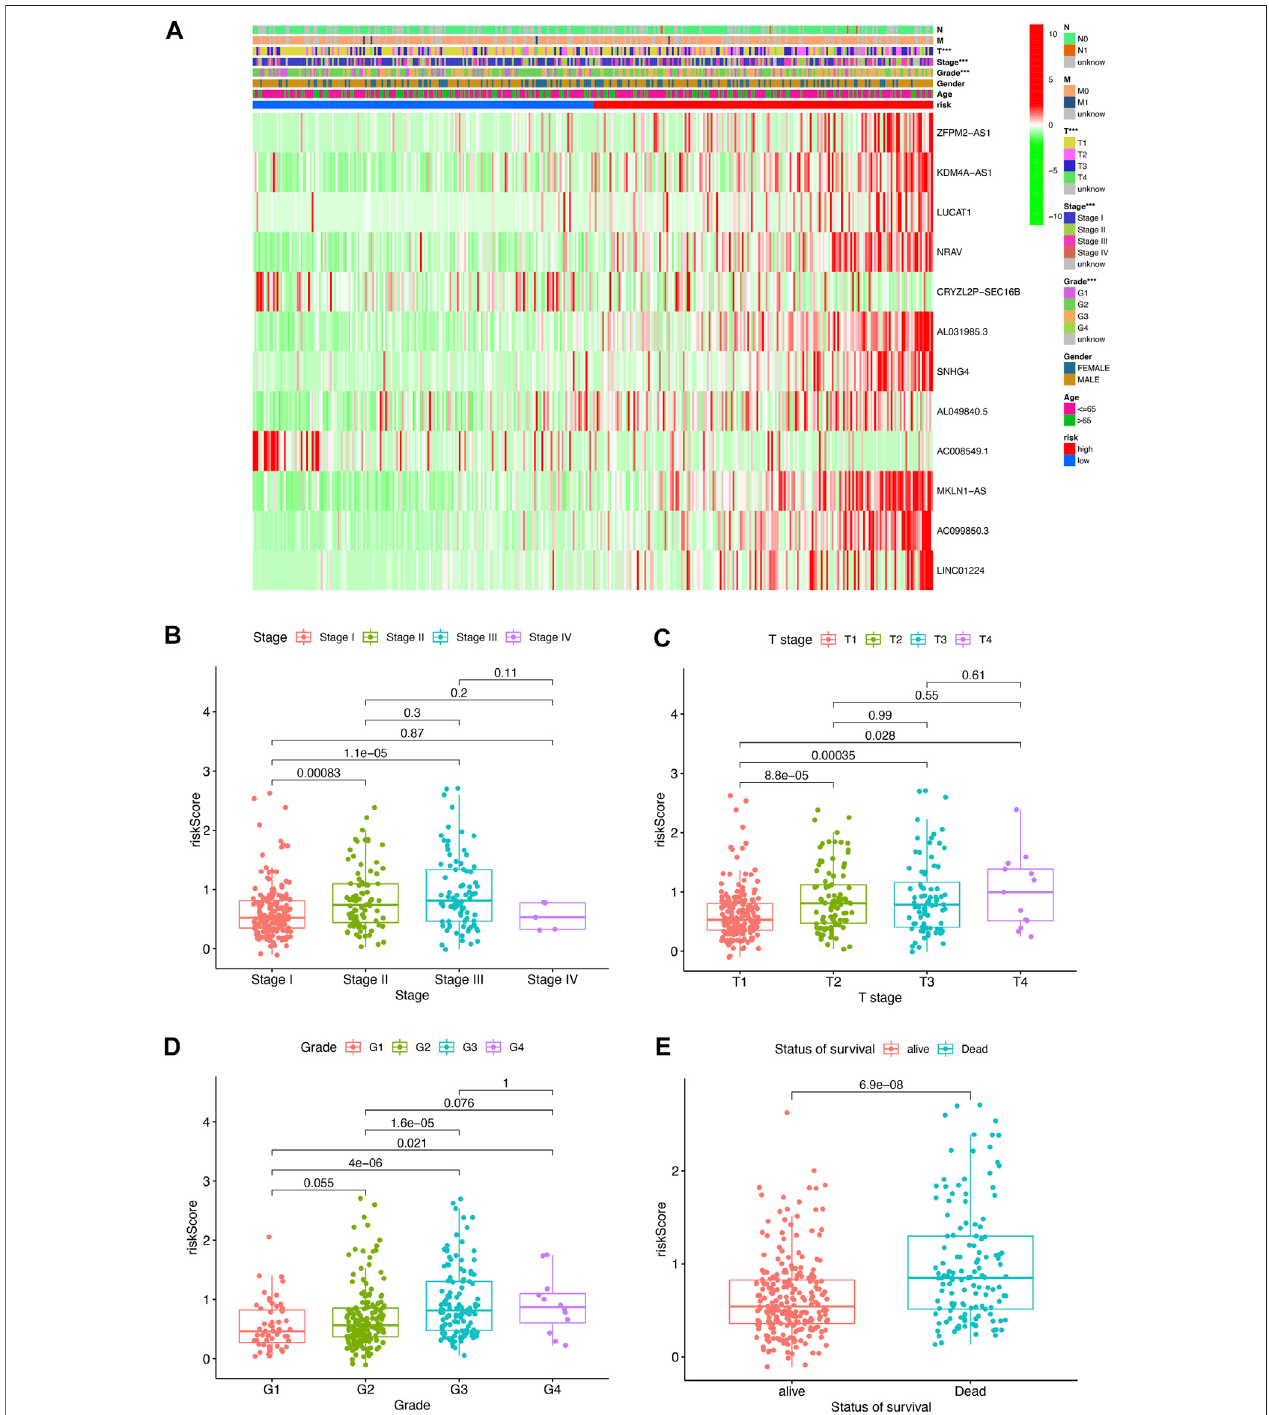
FIGURE3| Pyroptosis-relatedlncRNAriskscorewasassociated withtheclinicopathological charactersofpatients withHCC. (A) Heatmap for pyroptosis-related lncRNA risk score and clinicopathological manifestation. (B) Boxplot of pyroptosis-related lncRNA risk score in patients with different stage. (C) Boxplot of pyroptosis- related lncRNA risk score in patients with different tumor stage. (D) Boxplot of pyroptosis-related lncRNA risk score in patients with different pathological grade. (E) Boxplot of pyroptosis-related lncRNA risk score in patients with different status of survival.